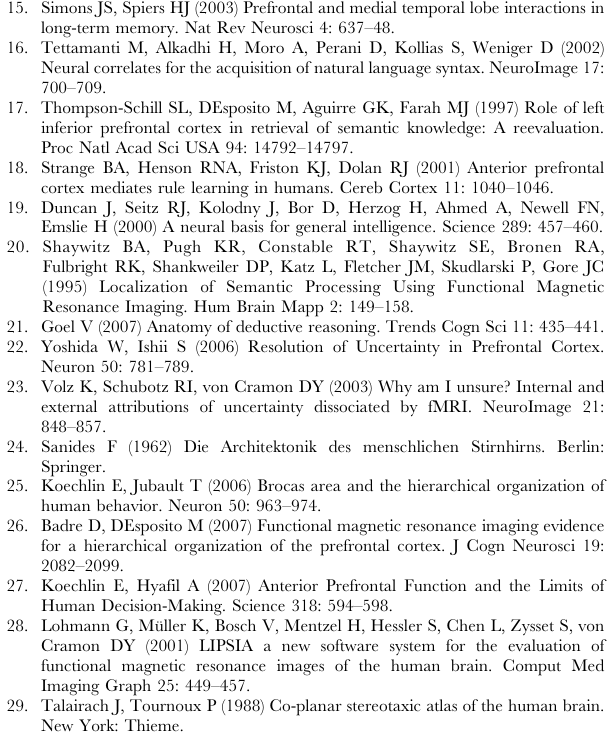
Found at: doi:10.1371/journal.pone.0005599.s008 (0.01 MB DOC) Found at: doi:10.1371/journal.pone.0005599.s009 (0.01 MB